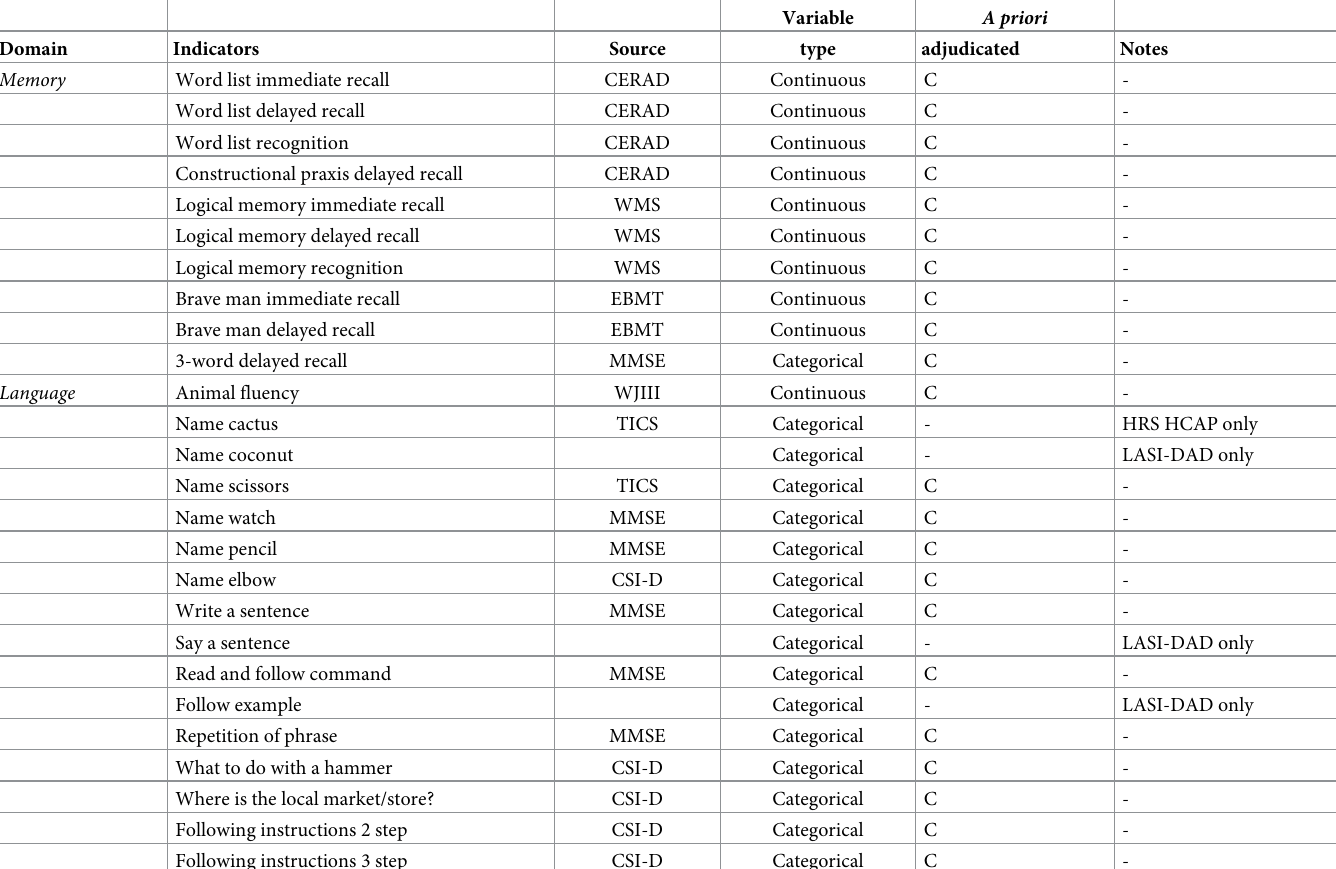
Table 1. Overview of variables considered comparable in the a priori adjudication process and DIF-modified analyses summarized by cognitive domain, including their availability for each